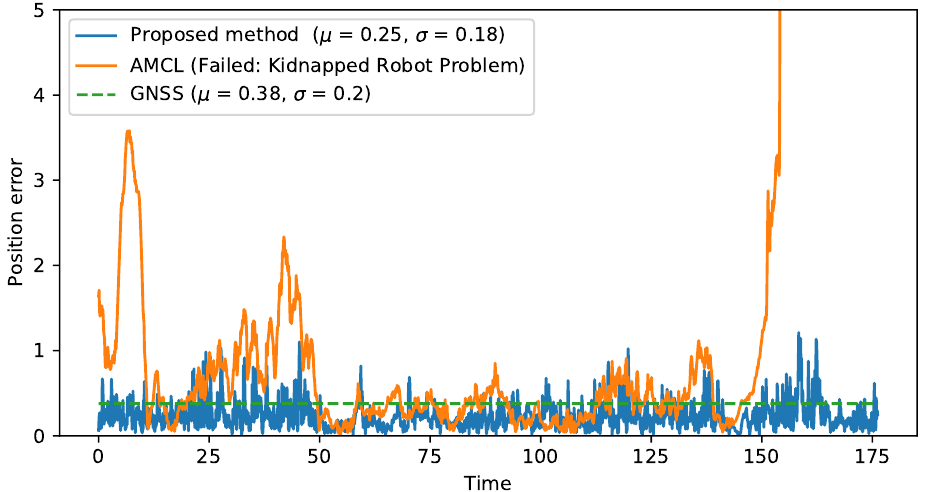
Figure 10. Comparison of the localization accuracy of the proposed method, original adaptive Monte Carlo localization (AMCL) and